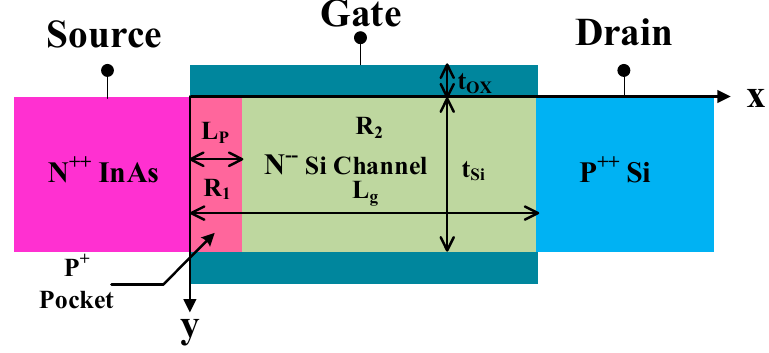
Figure 1. Schematic cross-sectional view of a p-type HSP-TFET.